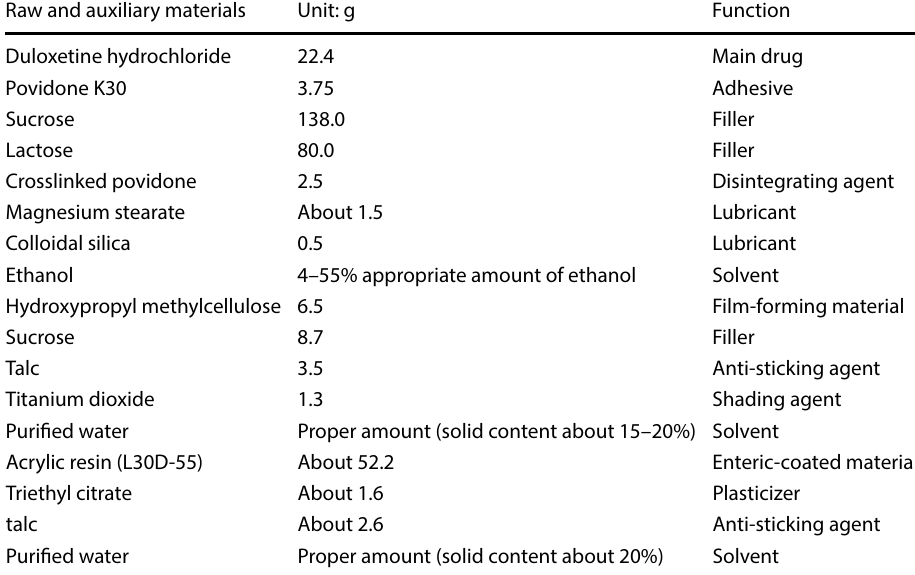
Table 6 Formulation: (calculated as 1000 tablets)